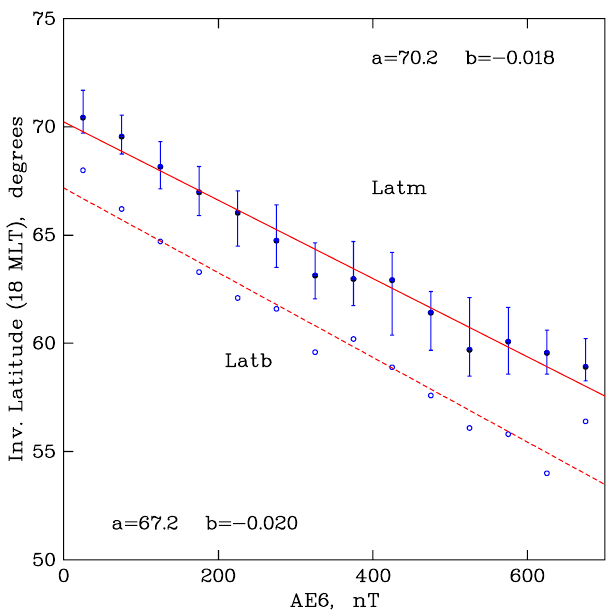
Fig. 3. Position of the equatorward trough wall as a function of ge- omagnetic activity. The AE 6 index is indicated on the abscissa, the associated invariant latitudes of the equatorward ( latb ) and pole- ward ( latm ) boundaries of the trough wall on the ordinate. The median and the upper and lower quartiles of these latter parameters were determined for each 50 nT- wide interval of the AE 6 index. In case of latm , these are indicated by the blue dots and bars. In the case of latb , only the respective medians are shown (open blue circles). In both cases, the quartile ranges are of comparable magni- tude. Linear regression lines were fitted to the median values ( latm : solid red line; latb : dashed red line). The associated ordinate inter- sections a (in degree) and slopes b (in degrees per nT) are given in the upper right-hand ( latm ) and lower left-hand ( latb ) corners, respectively. Note that the results presented in this figure refer to a magnetic local time of 18:00h. Also note that only relatively few data points are available for AE 6 values larger than, say,